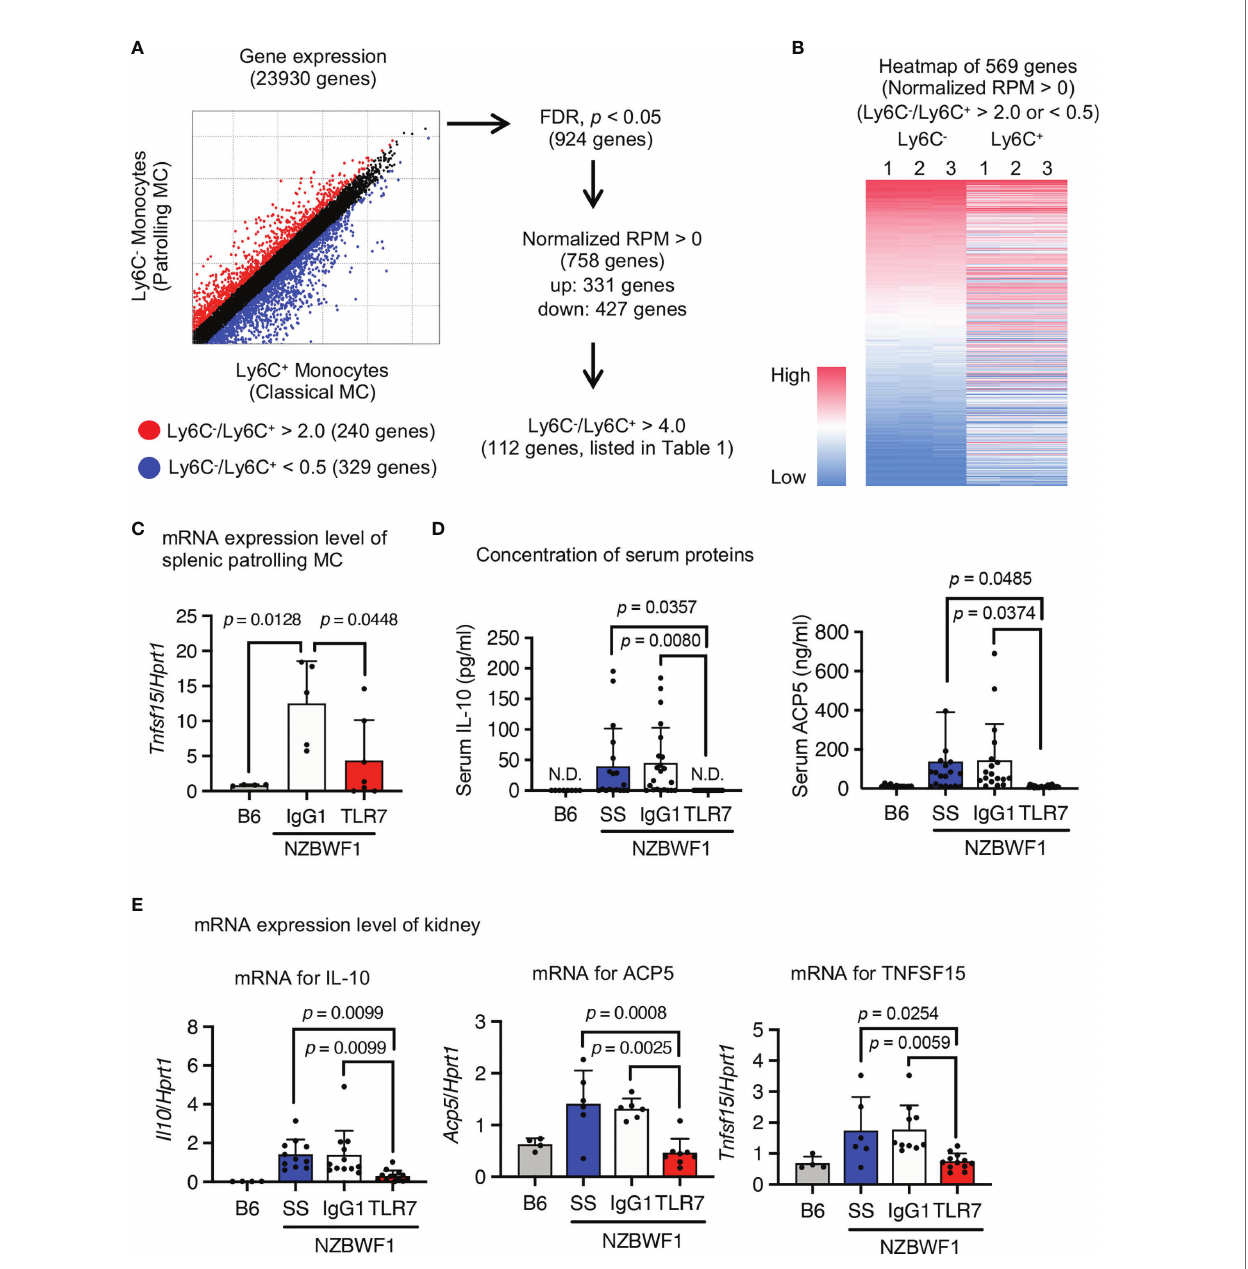
FIGURE 7 | Expression of SLE-associated genes in patrolling monocytes in NZBWF1 mice. Expression of 23,930 analyzed genes in patrolling monocytes and classical monocytes of NZBWF1 mice aged 30-35 weeks. Red and blue dots show genes with expression ratios in patrolling monocytes compared with classical monocytes that were > 2 or < 0.5, respectively. We identi fi ed 924 signi fi cantly changed genes ( p < 0.05; Benjamin-Hochberg FDR tests), and 758 with normalized expression (reads per million, RPM) > 0. Among them, the expression of 331 genes was considered as upregulated in patrolling monocytes compared with classical monocytes. Among these 331 genes, 112 with a patrolling/classical expression ratio > 4 are shown in Supplementary Table 1 . (B) Heatmap of RPM of 569 genes (red and blue dots in (A) in descending order based on that of patrolling monocytes. Results are from individual samples (1 – 3). (C – E) NZBWF1 mice administered saline, IgG1 or anti-TLR7 mAb from age 12-16 to 35-40 weeks compared with age-matched B6 mice. (C, E) Expression of mRNAs encoding indicated genes in splenic patrolling monocytes (C) and kidney (E) were analyzed by real-time PCR. Results are normalized by Hprt1 mRNA. (D) Concentration of IL-10 and ACP5 in serum measured by ELISA. B6 ( n = 4), saline ( n ≥ 6), control IgG1 ( n ≥ 5), and anti-TLR7 mAb ( n ≥ 6). Data were statistically analyzed using one-way ANOVA. The results found signi fi cant by ANOVA ( p < 0.05) were further assessed by Tukey ’ s multiple comparison tests and the p -values are shown (C – E) . Data are shown as individual points and as means ± SD for each experimental group (C – E)